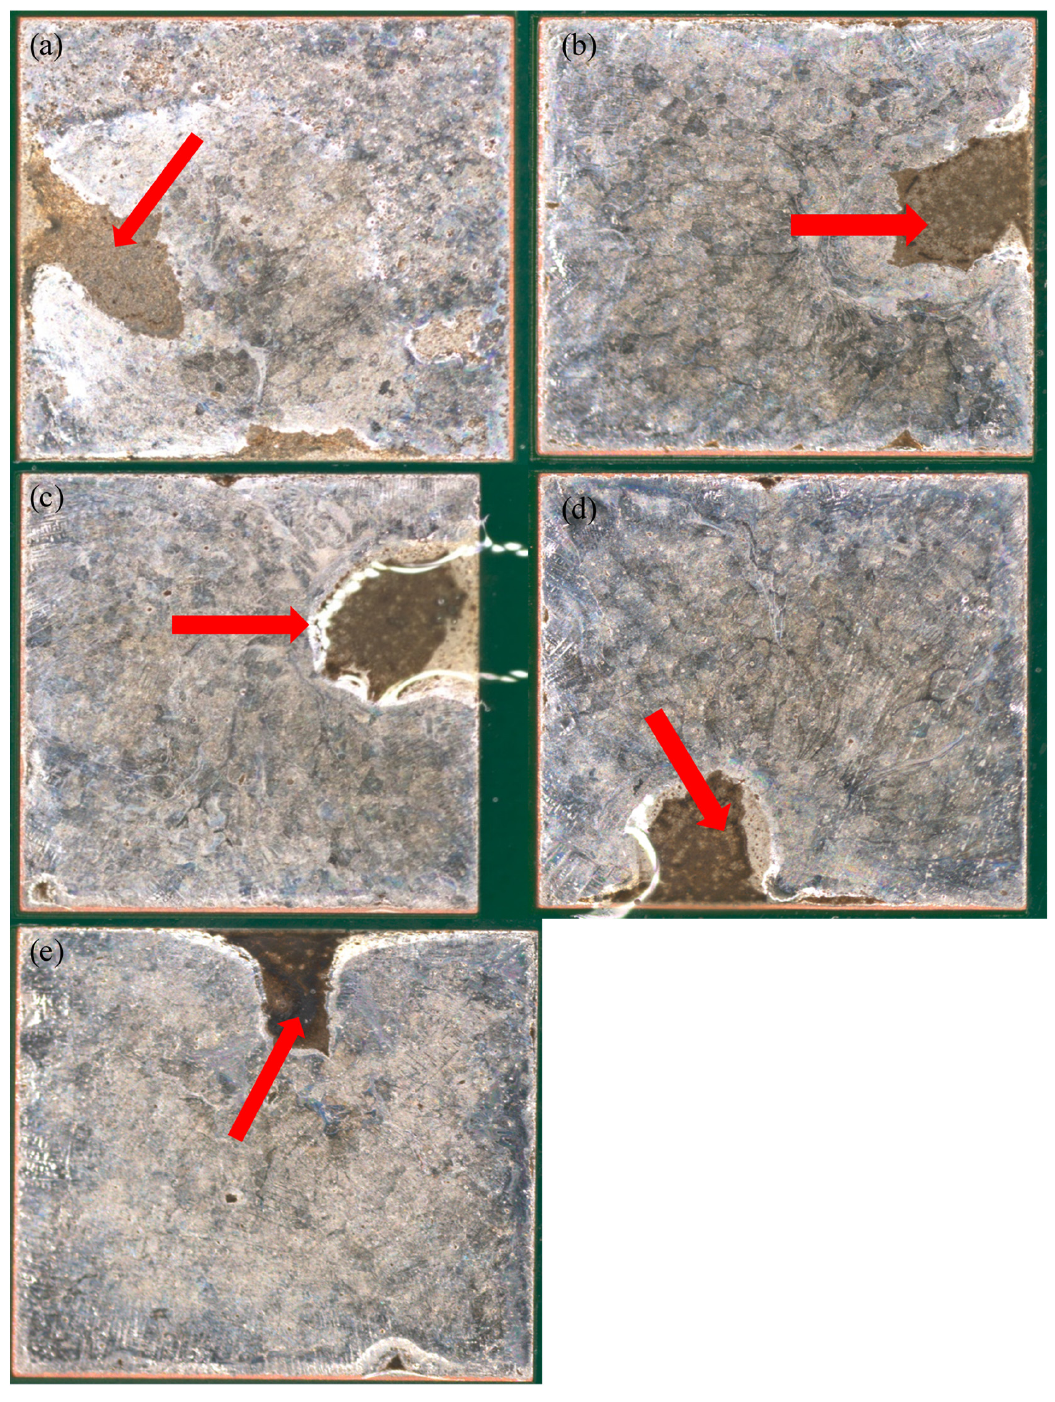
Figure 4. Optical images of 42Sn57Bi1Ag reflowed with ( a ) a peak temperature of 165 °C and 45 s TAL, ( b ) peak temperature of 165 °C and 90 s TAL, ( c ) peak temperature of 177 °C and 45 s TAL, ( d ) peak temperature of 177 °C and 90 s TAL and ( e ) peak temperature of 190 °C and 90 s TAL. Red arrows indicate areas where the alloy does not cover the copper substrate.